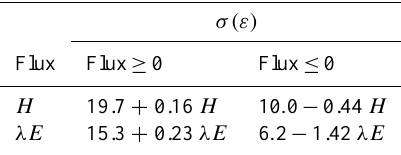
Table 6. Standard deviation of the random flux error, σ(ε) , for forests. σ(ε) scales with the magnitude of the flux (Richardson et al., 2006,